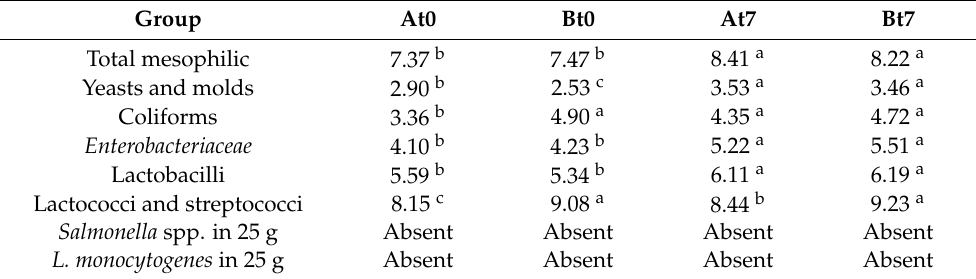
Table 3. Microbial counts (log cfu g − 1 ) in the cheese samples from trials A and B at 0 and 7 days of refrigerated storage. Values in the same row bearing different superscripts are different at p <